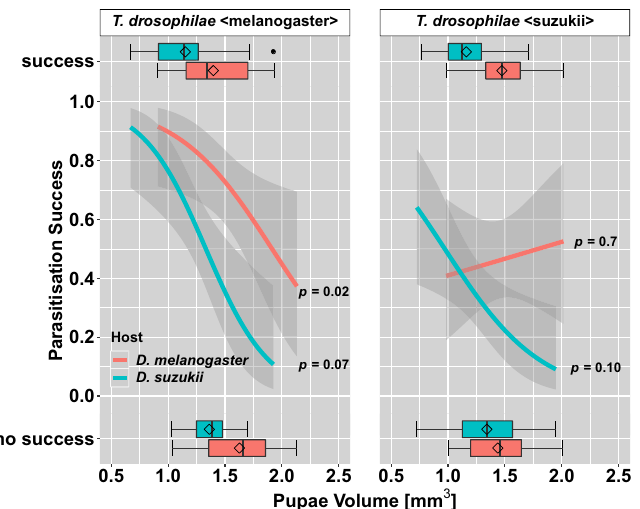
Figure 4. Proportions with a 95% confidence interval of parasitisation success on D. suzukii (blue) and D. melanogaster (red) pupae in relation to pupal volume. The wasp T. drosophilae was reared on D. melanogaster pupae (left side) and D. suzukii pupae (right side). The variation of success and no success of parasitisation to the volume of parasitised pupae is given in the box plots on top and bottom (for GLMMs see Table S2).